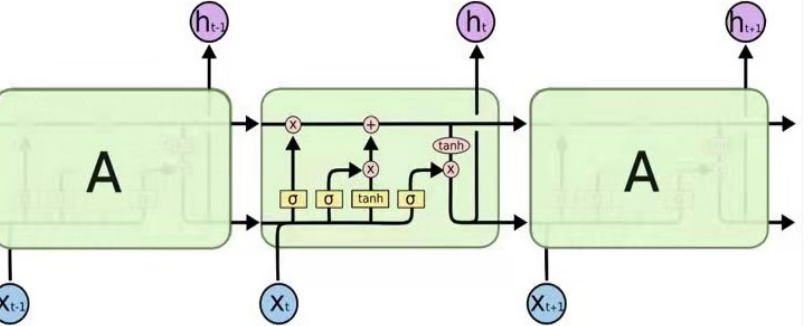
Figure 6. Long short-term memory network topology diagram.